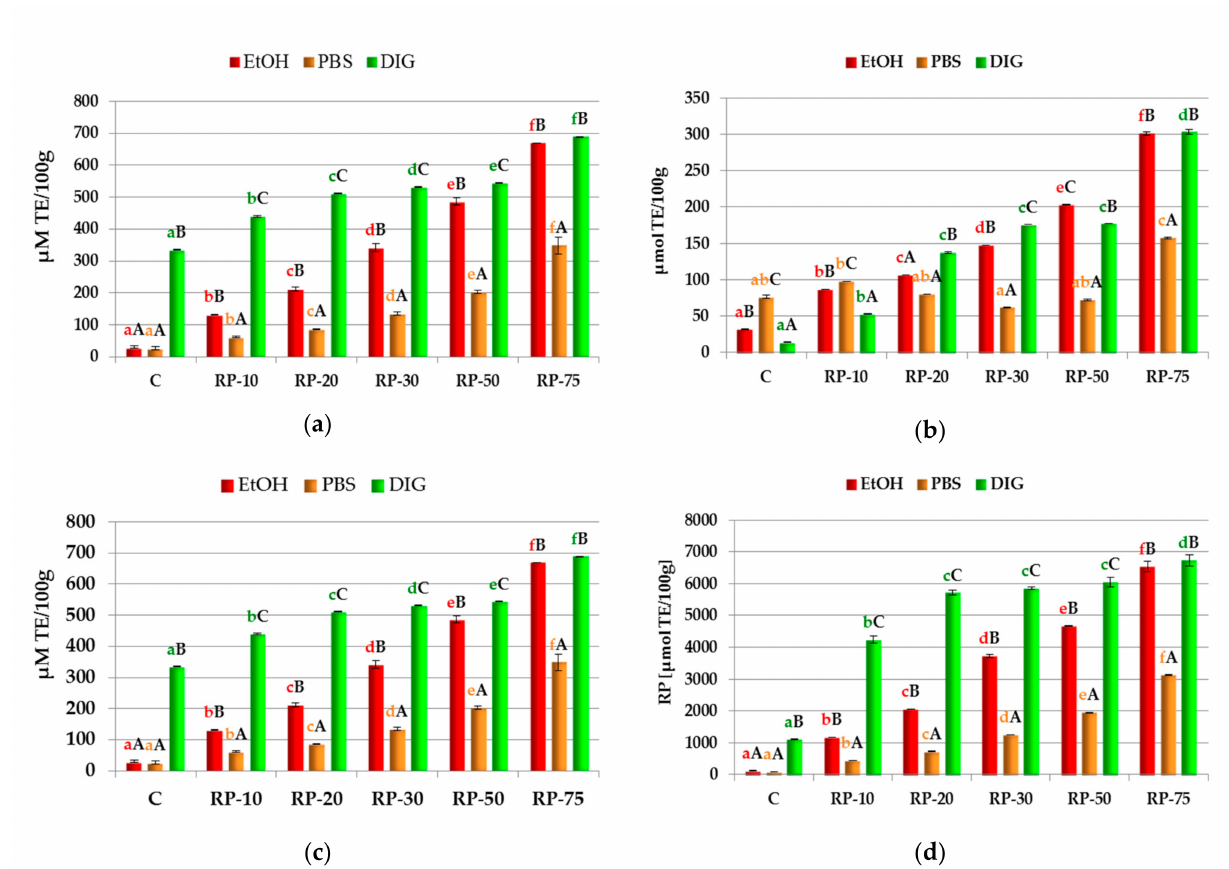
Figure 3. Antioxidant properties of wafers fortified with freeze-dried raspberry pomace: ( a ) ability to neutralize ABTS • + radicals, ( b ) ability to neutralize DPPH • radicals, ( c ) ability to chelate iron ions (CHP), ( d ) reduction power (RP). C—wafers without raspberry pomace (control), RP-10–RP-75—wafers with 10% to 75% raspberry pomace addition, respectively. All values are mean ± standard deviation for triplicate experiments. Means with different small letters show significant differences between samples with different % of supplementation (red—EtOH, orange—PBS, green—DIG) at p ≤ 0.05. Values denoted by the different capital letters are statistically different within the same sample but between the different types of the extract ( p <